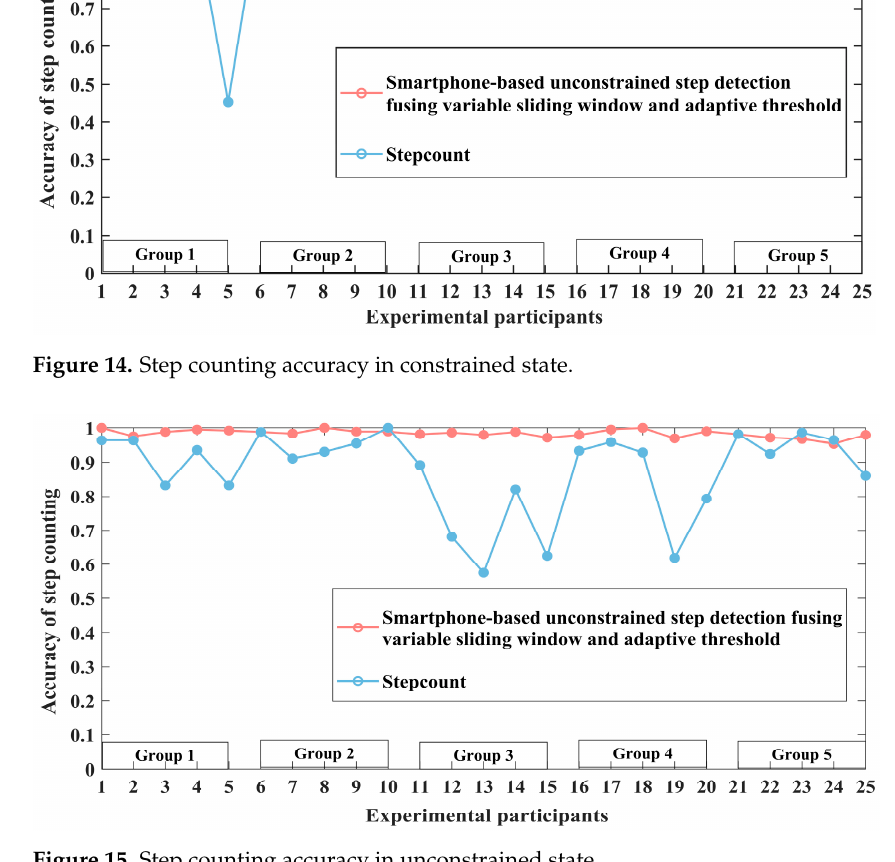
Figure 16. Step counting accuracy rate of smartphones with different prices in unconstrained state.